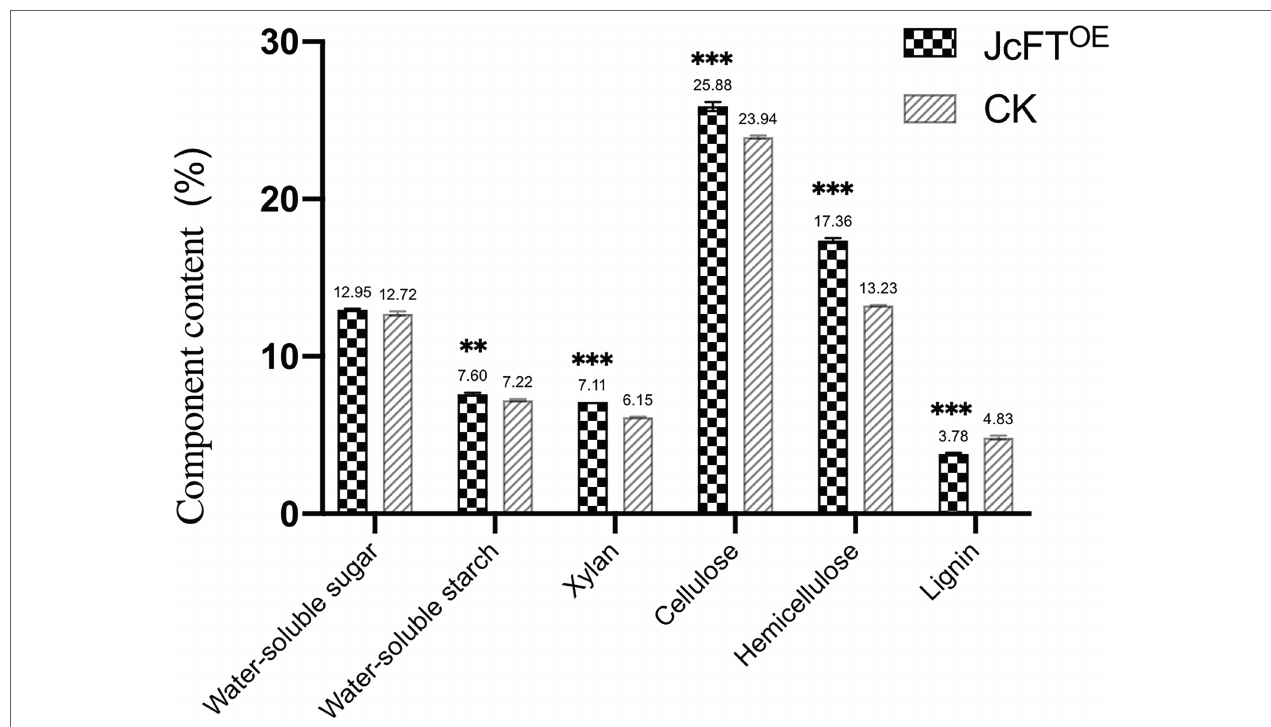
FIGURE 8 | Carbohydrate components in tobacco stems of JcFT OE and control (CK) plants (The values represented mean, the vertical bars indicated standard deviation, n = 3, ** p < 0.01; *** p <